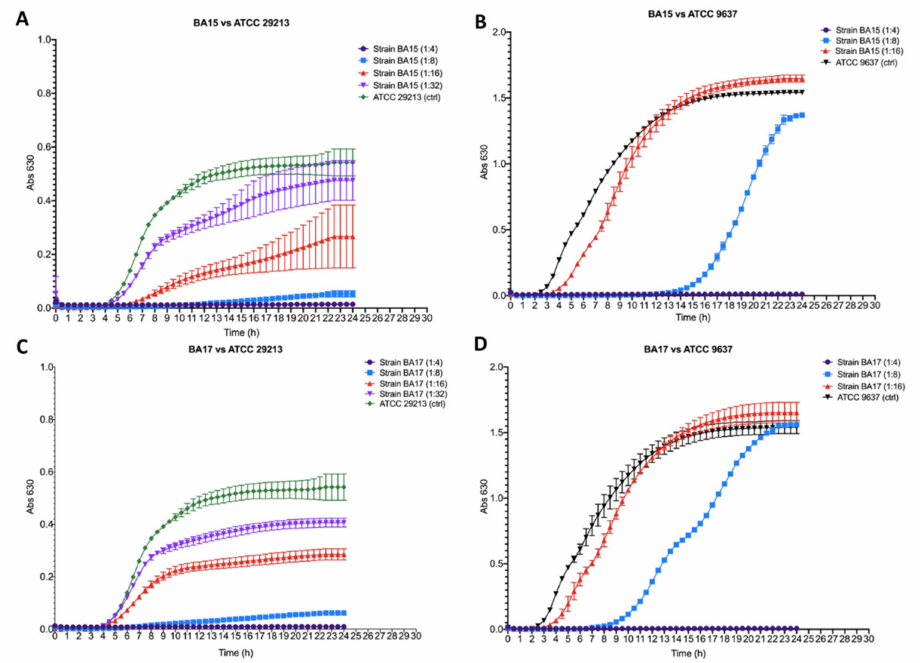
Figure 5. Killing curves of the cells free supernatants (CFS) obtained from 96 h broth cultures of Bifidobacterium asteroides BA15 (CFS BA15 ) and Bifidobacterium asteroides BA17 (CFS BA17 ) at different dilution factors: 1:4 (purple curve); 1:8 (light blue curve); 1:16 (red curve); 1:32 (light purple curve), against Escherichia coli ATCC 9637 (black curve) and Staphylococcus aureus ATCC 29213 (green curve). Killing curves of CFS BA15 ( A ) against E. coli ATCC 9637; ( B ) against S. aureus ATCC 29213. Killing curves of CFS BA17 ( C ) against S. aureus ATCC 29213; ( D ) against E. coli ATCC 9637.